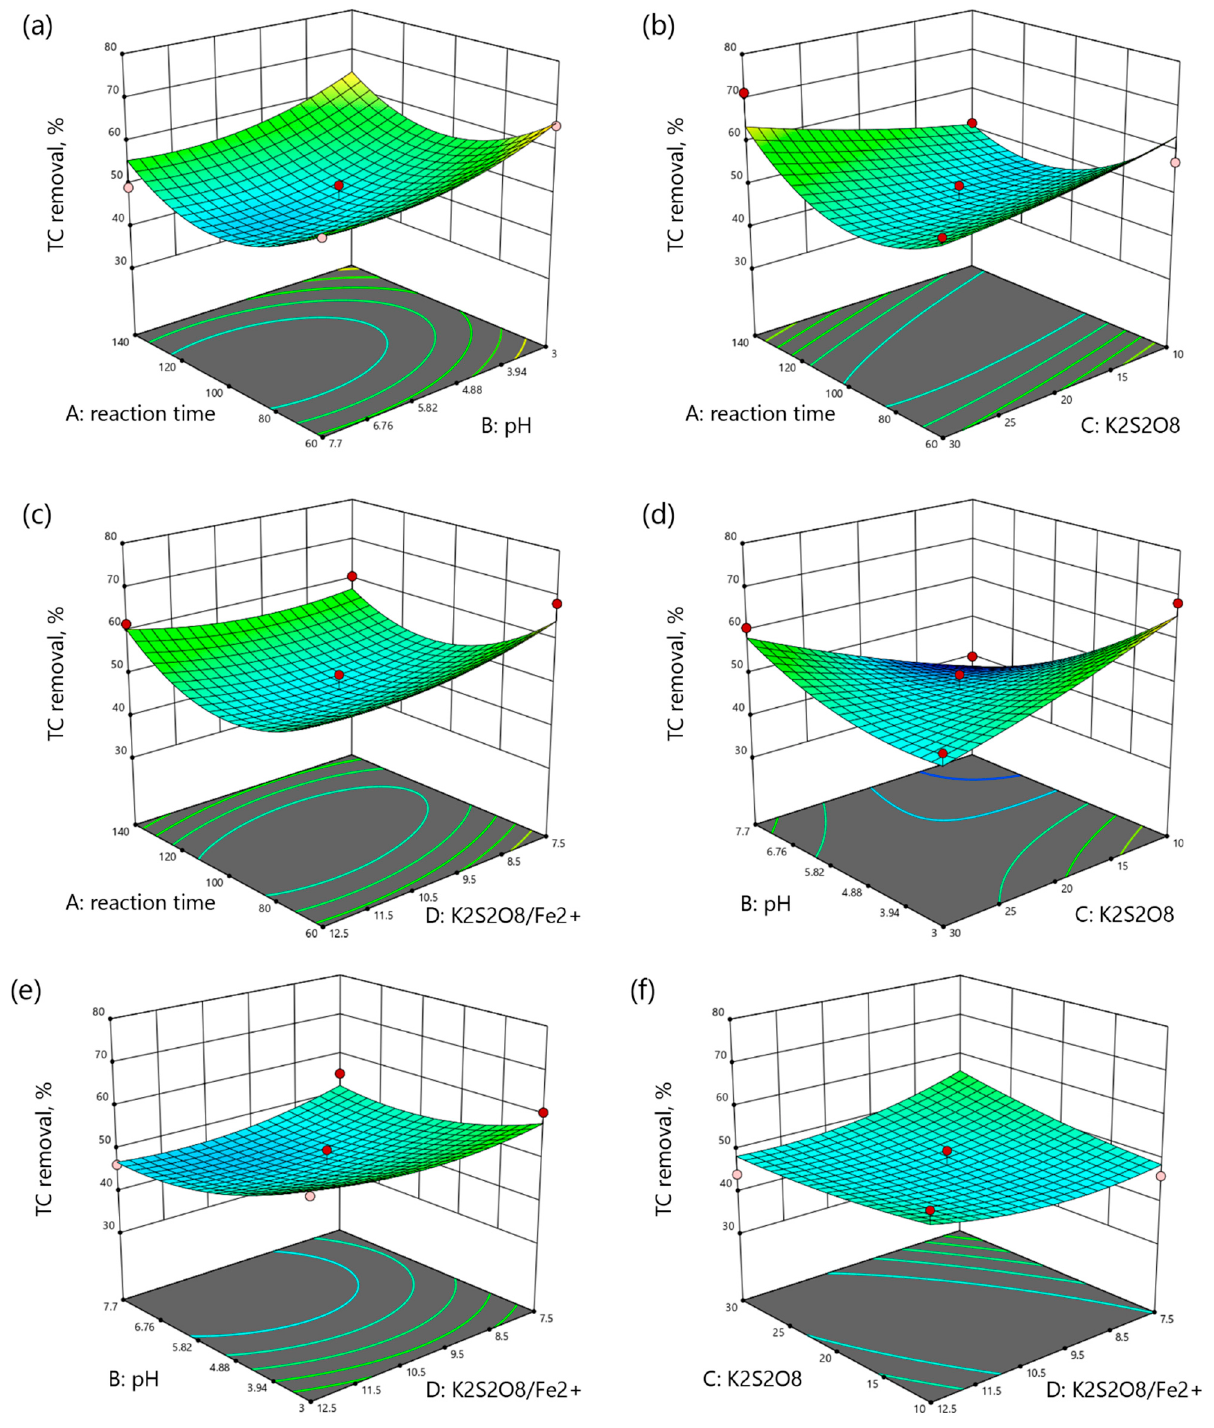
Figure 3. 3D plots of TC removal as a function: ( a ) reaction time (min) and pH, ( b ) reaction time (min) and K 2 S 2 O 8 concentration (mM), ( c ) reaction time and K 2 S 2 O 8 /Fe 2+ molar ratio, ( d ) pH and K 2 S 2 O 8 concentration (mM), ( e ) pH and K 2 S 2 O 8 /Fe 2+ molar ratio, ( f ) K 2 S 2 O 8 concentration (mM) and K 2 S 2 O 8 /Fe 2+ molar ratio.